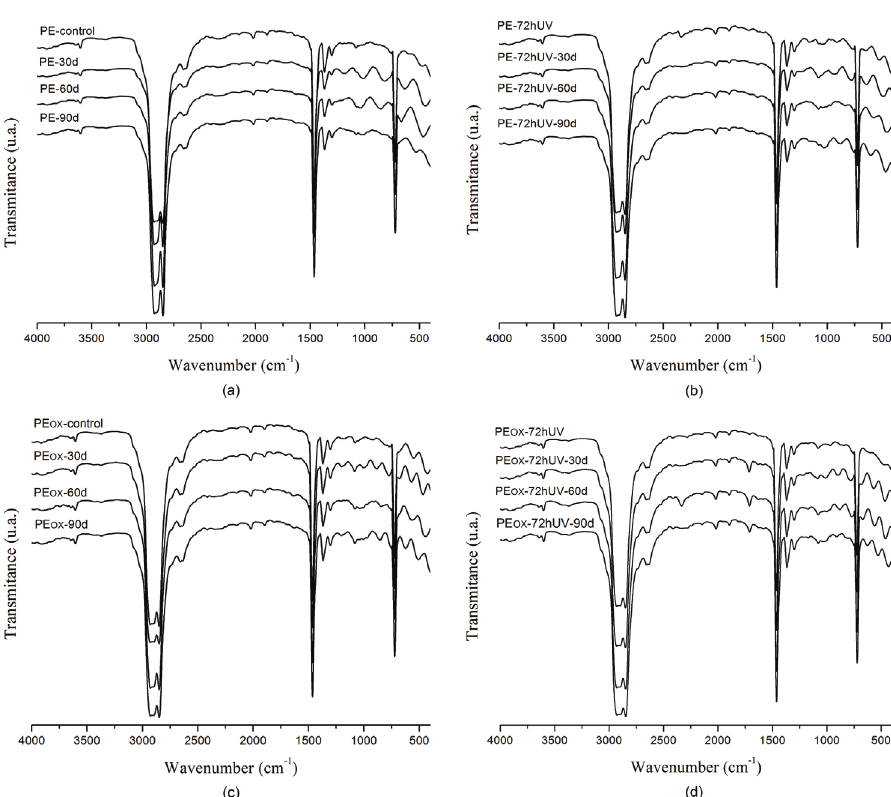
Figure 6. FTIR spectra of (a,c) PE and PE of exposure in accelerated aging and after 30, 60 and 90 days in simulated